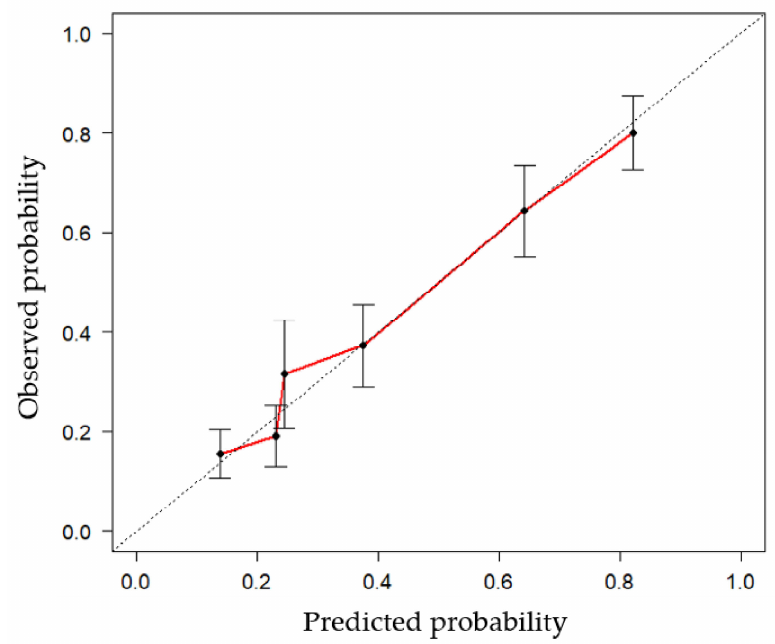
Figure 4. The plotted calibration curve shows good agreement between the predictive probability of the nomogram and the actual LN status. The red line indicates the performance of the nomogram, whereas the black dashed line indicates the actual LN status, as confirmed by the pathology results. Abbreviations: LN, lymph node.